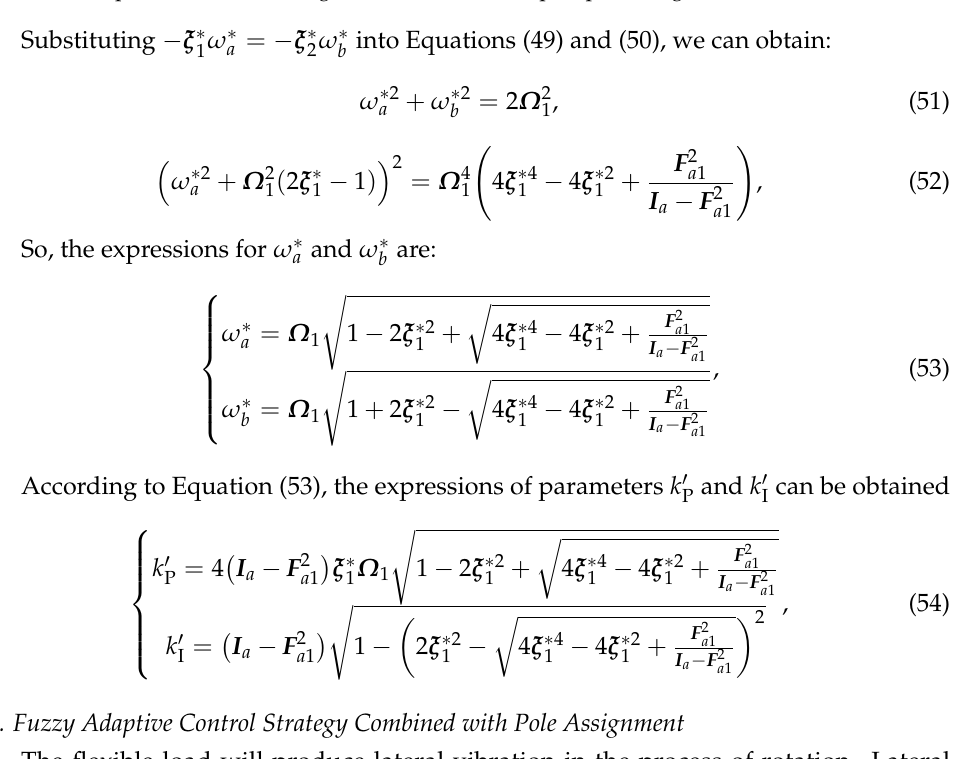
Figure 3. Zero pole distribution diagram of the same real-part pole assignment